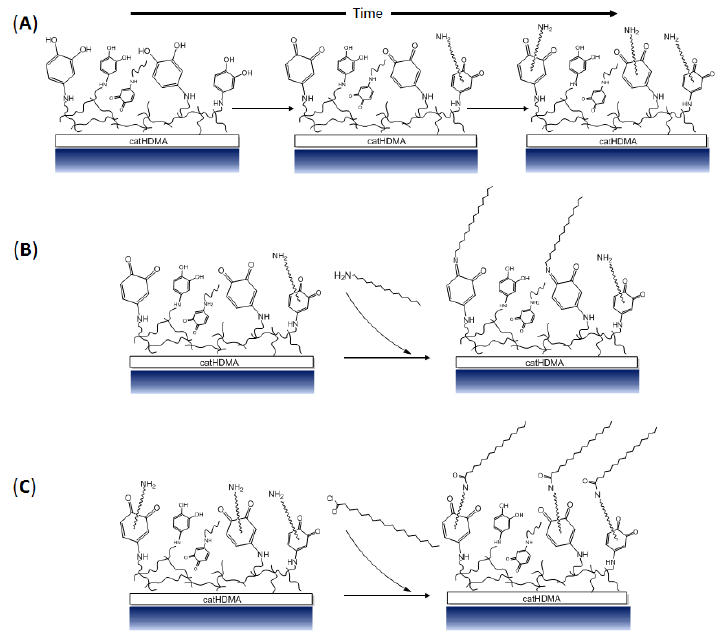
Figure 9. Chemical structure of the catHMDA coating and its functionalization. ( A ) Tentative schematic representation of the primer coating (catHDMA) and its evolution in function of the reaction time, where an increase in the amount of quinones and non-reacted amine tail ends can be observed. ( B ) Proposed schematic mechanism of the attachment of 1-hexadecanamine to catHDMA-16 h (the optimal generation time of the primer coating for its functionalization with this reagent is 16 h) ( C ) Proposed schematic mechanism of the attachment of stearoyl chloride to catHDMA-48 h (the optimal generation time of the primer coating for its functionalization with this reagent is 48